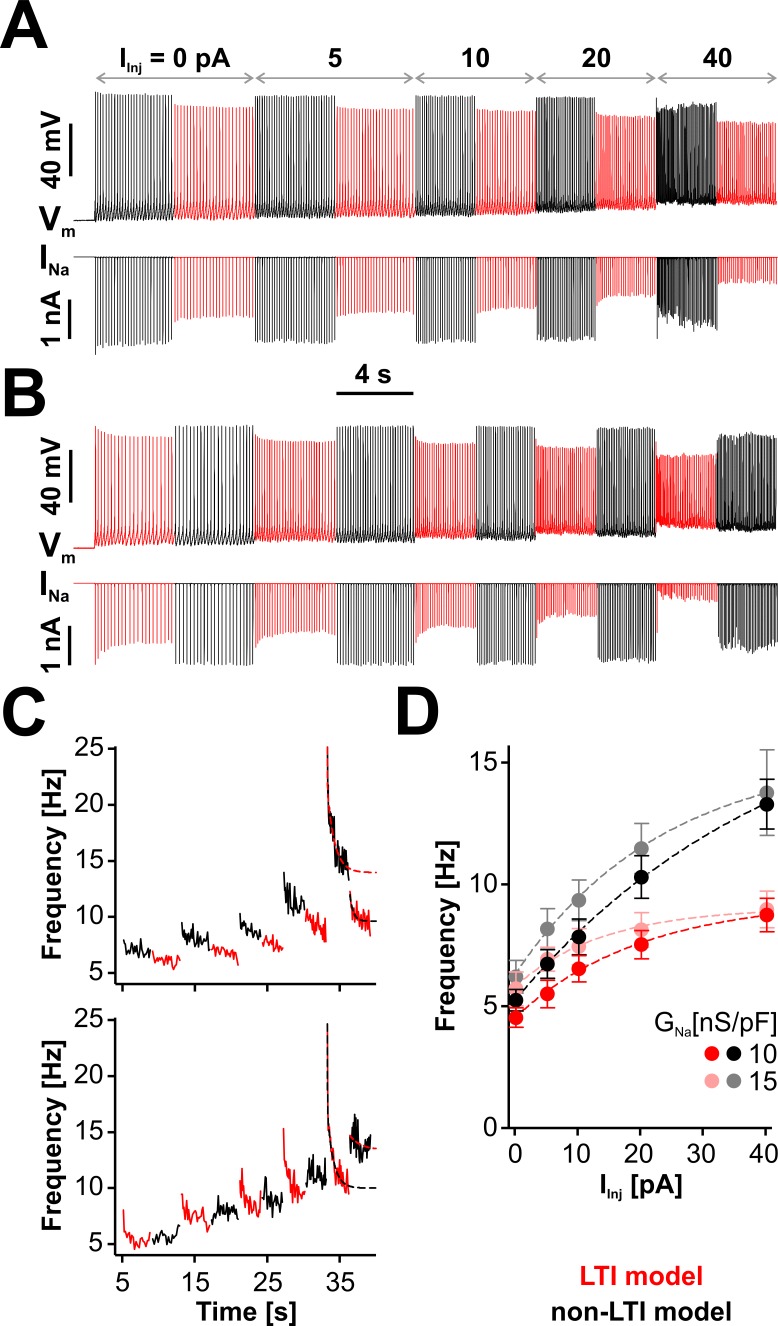
LTI helps the neuron to maintain a low spiking frequency against sustained depolarizations.(A) Representative dynamic clamp recording, where INa (lower trace) generated by the LTI (red) or non-LTI (black) model was injected in a neuron, under increasing depolarizing current (IInj). Both models are integrated throughout the entire protocol, but only one model at a time injects current in the cell. In this example, GNa was 10 nS/pF. Before the protocol started, the neuron was clamped at −65 mV for 5 s. (B) Same as in (A), but the models were alternated in the opposite order. (C) Instantaneous spiking frequency extracted from the recording shown in (A) (upper panel) or (B) (lower panel). (D) Quasi steady-state spiking frequency vs. IInj (mean ± SE, n = 13). The values were obtained by averaging over the second half of each step, from traces obtained with the protocol shown in (A). The datasets are statistically different (paired two-tailed t-test) for LTI vs. non-LTI model (p=0.0387 or 0.0374, for GNa = 10 or 15 nS/pF, respectively) and for GNa = 10 vs. 15 nS/pF (p=0.0143 or 0.0038, for LTI or non-LTI model, respectively). The dashed lines in (C) and (D) are exponential fits meant as a visual aid. The data were obtained from RO neurons in neonatal rat brainstem slices.Figure 6—source data 1.Frequency vs. IInj for LTI and non-LTI models, as shown in panel D.